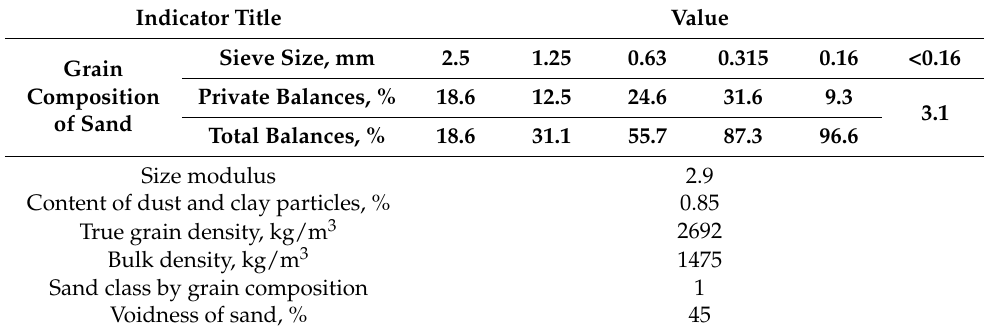
Table 3. Characteristics of quartz sand.